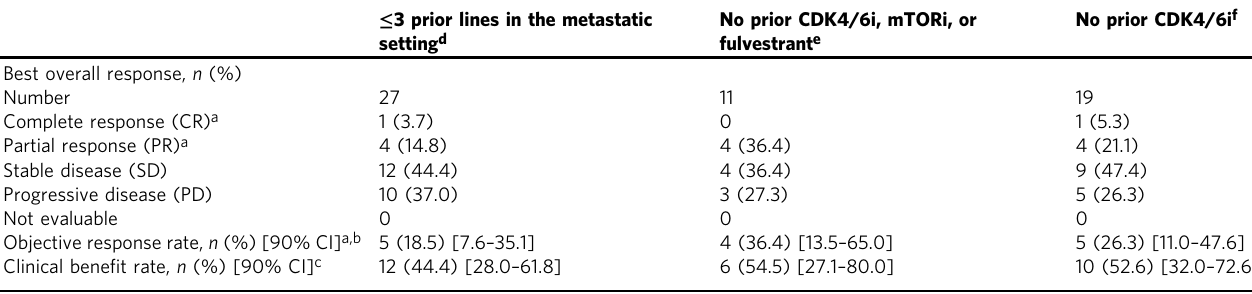
Table 5 Post hoc subgroup analyses by <3 prior lines of therapy in the metastatic setting, by no prior CDK4/6 or mTOR inhibitors or fulvestrant, and by no prior CK4/6 inhibitors in the Part B response-evaluable population by independent central review.